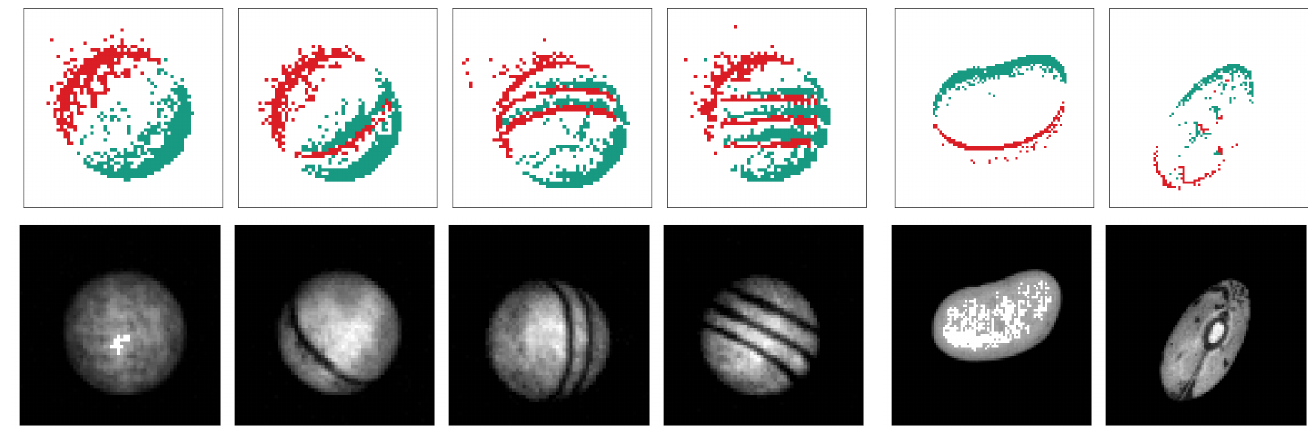
Figure 9. Samples of the preprocessed ball ( left side ) and bean dataset ( right side ). All data have been recorded with a DAVIS346 and preprocessed by the event-based pipeline presented in this paper. After an initial noise filtering, a tracking algorithm based on events only tracks the object’s center. All events and frames of a detected object are compressed to an ROI of constant size around the center. The upper row shows the resulting event stream where positive events are marked in green and negative in red (animated in the digital version of this manuscript). In the lower row sections of conventional gray scale images of the DAVIS camera are displayed that have been extracted by the